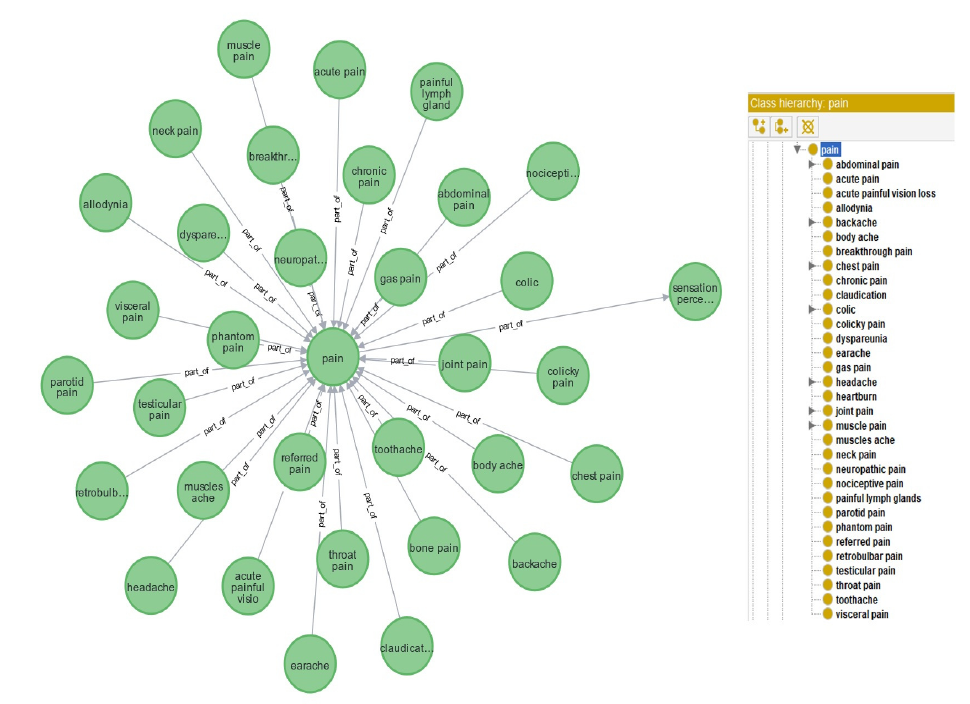
Figure 6. A subgraph of ‘pain’ symptom with its superclass, subclasses, and the corresponding SYMP